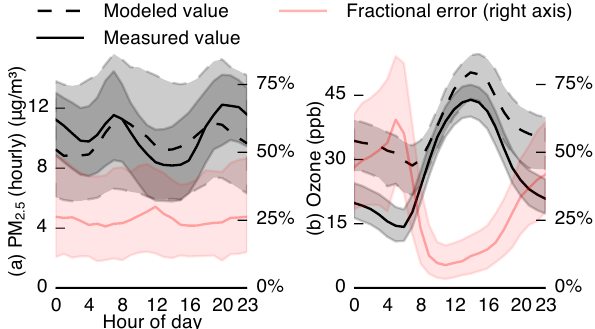
Figure 4. Median values (lines) and interquartile ranges (shaded areas) of annual average modeled values, observed values, and frac- tional error by hour of day for (a) PM 2 . 5 and (b) O 3